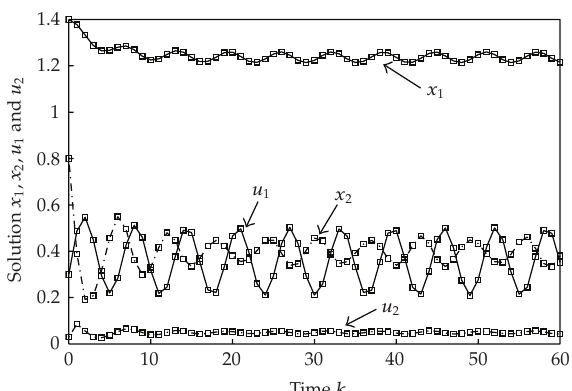
Figure 1: Dynamics behaviors of system (cid:3) 1.3 (cid:4) with initial condition (cid:3) x 1 (cid:3) p (cid:4) ,x 2 (cid:3) p (cid:4) ,u 1 (cid:3) p (cid:4) ,u 2 (cid:3) p (cid:4)(cid:4) (cid:5) (cid:3) 1 . 4 , 0 . 8 , 0 . 3 , 0 . 03 (cid:4) (cid:3) P (cid:5) − 1 , 0 (cid:4)